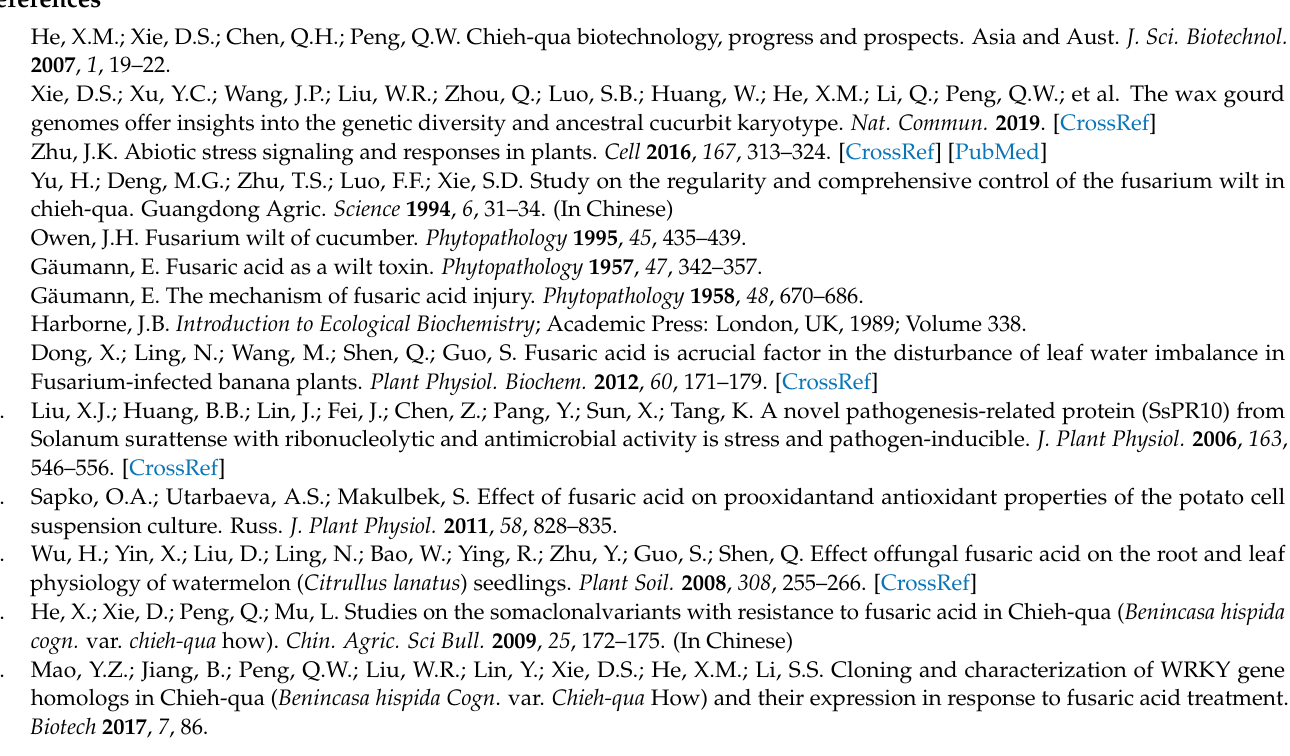
Figure S2: SNP analysis of A39 and H5 under normal and FA stress. Figure S3: GO analysis of A39 and H5 under normal condition and FA stress. Table S1: Primers used in qRT-PCR, Table S2: Table S3: DEGs between A39 and H5 before FA stress treatment. Table S4: DEGs between A39 and H5 under FA stress treatment. Table S5: Genes of qRT-PCR identification. Tables S6 and S7: SNP variation and detection analysis. Table S8: Gene Ontology (GO) analysis. Table S9: The main 20 pathways. Table S10: The most enriched pathways under FA